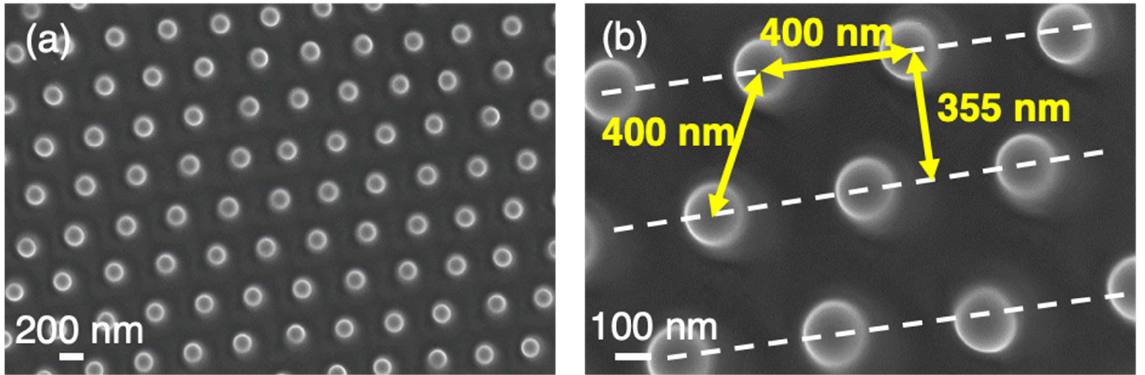
Figure 7. ( a ) Top-view SEM (in-lens) micrographs of hexagonal-lattice self-ordered nanostructures on Ni5W tape. ( b ) Detail of the structure with main dimensions. The dashed white lines indicate the orientation of the original LSFL-I type ripples. The yellow double-arrows indicate characteristic separation distances.